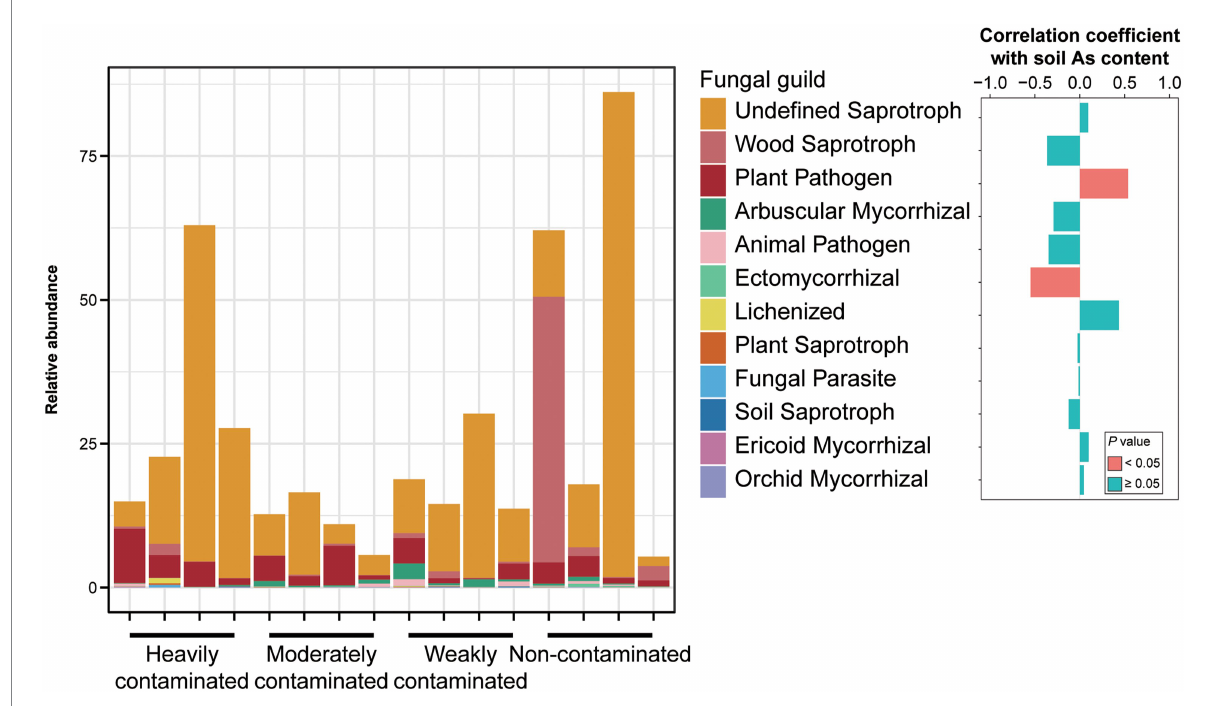
FIGURE 5 Relative abundances of fungal functional groups in Pteris vittata rhizosphere soil with different levels of arsenic contamination in the field. The bar plot on the right shows the correlation coefficients between these fungal guilds and soil arsenic content. The colors of the bars indicate the significance of the correlations between the relative abundance of soil fungal guilds and soil arsenic content (red: p < 0.05, green, p >